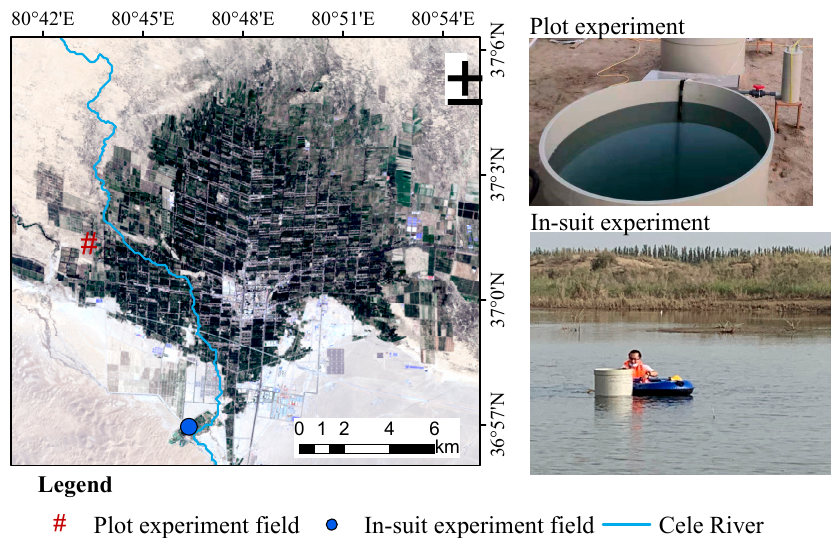
Figure 2. Locations of plot experiment and in-situ experiment.